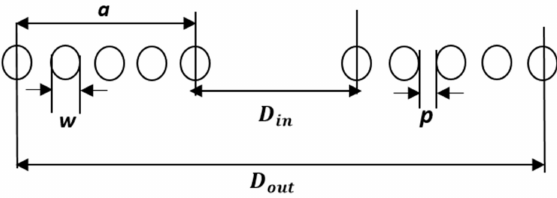
Figure 17. A cross-sectional view of the flat circular